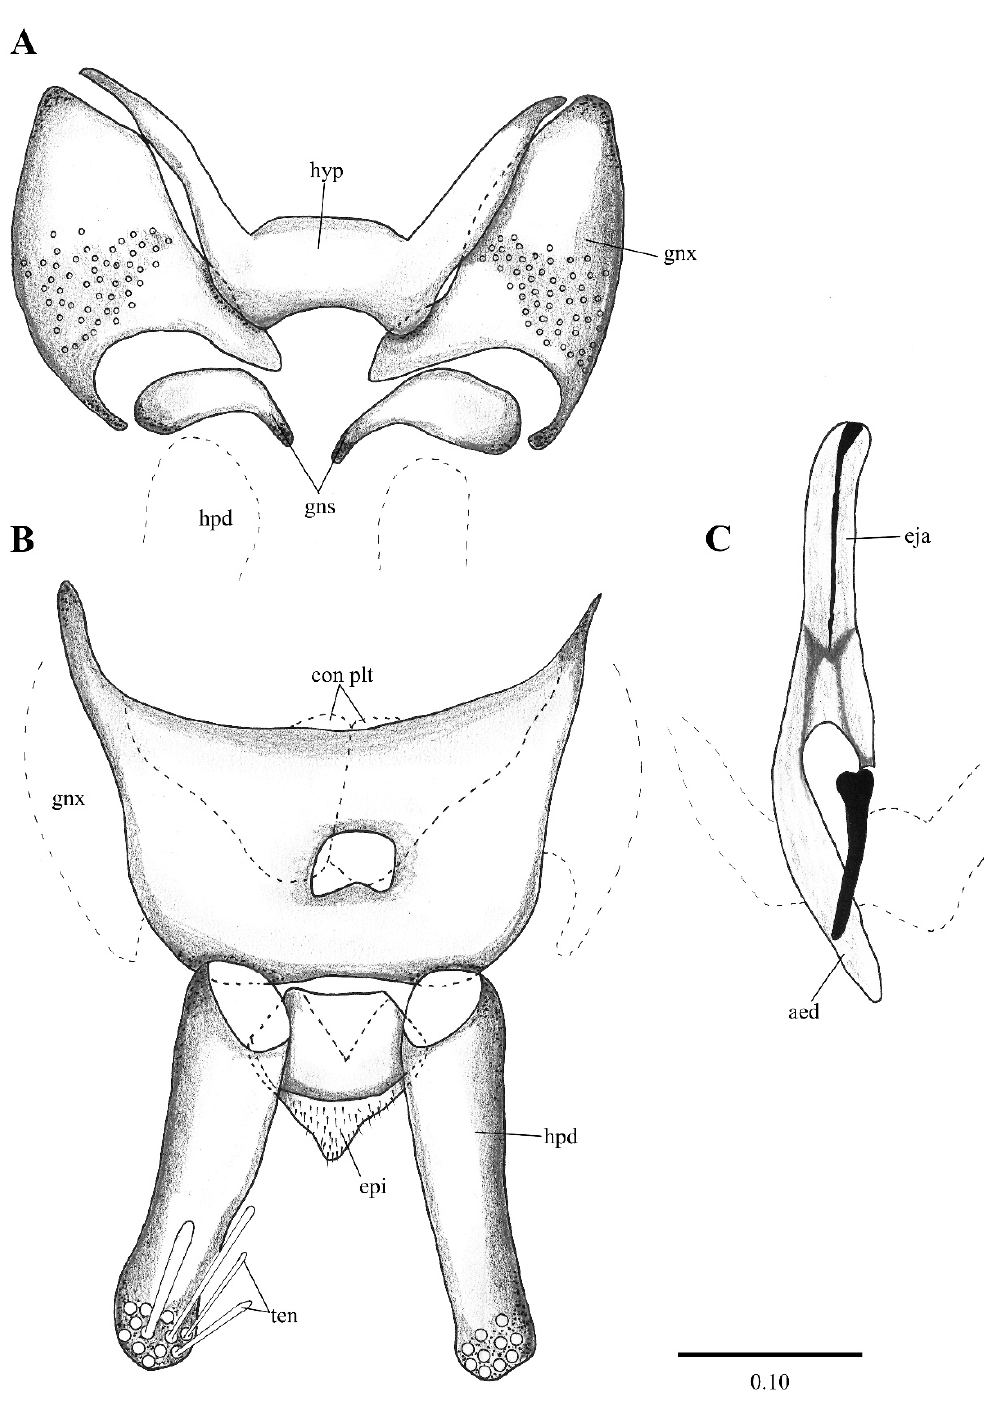
Figure 3. Lepiseodina rothschildi (Eaton, 1912), male genitalia. ( A ). Hypandrium, gonocoxites and gonostylus. ( B ) Epandrium, hypopods, tenacula, hypoproct. ( C ) Aedeagus. Abbreviations: aed = aedeagus, con plt = condyle plate-like, eja = ejaculatory apodeme, epi = epiproct, gnx = gonocoxite gns = gonostylus, ten = tenacula, hyp = hypandrium. Scale ( A – C ) in millimeters (mm).